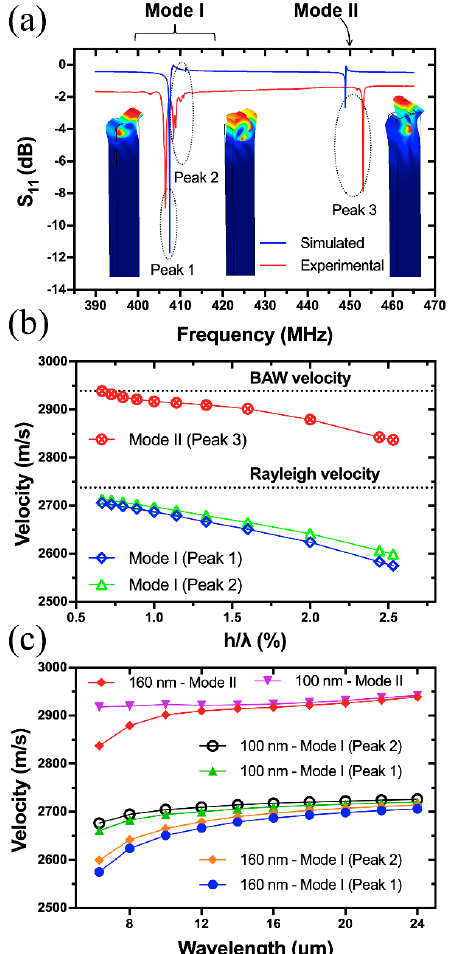
Figure 3. Comparison of the simulated and experimental S 11 spectra of Device A ( λ = 6.32 µ m) ( a ); Dispersion relations between acoustic velocity and normalized Pt electrode thickness ( h / λ ) for the two modes of Device A ( b ); Modulation effect of Pt electrode thickness on acoustic velocities of Device A ( c ).